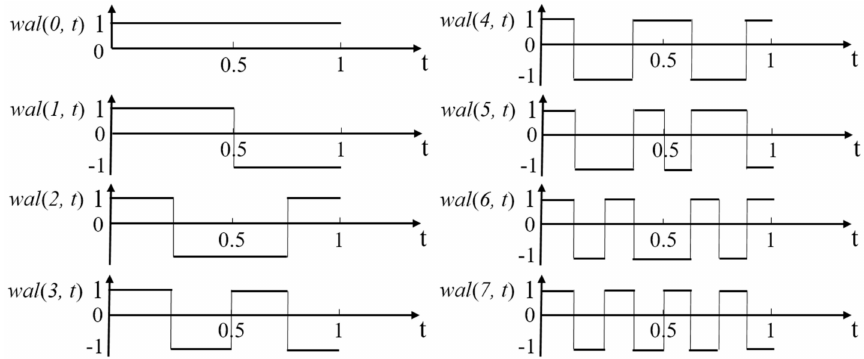
Figure 1. Illustration of first eight Walsh series adapted from